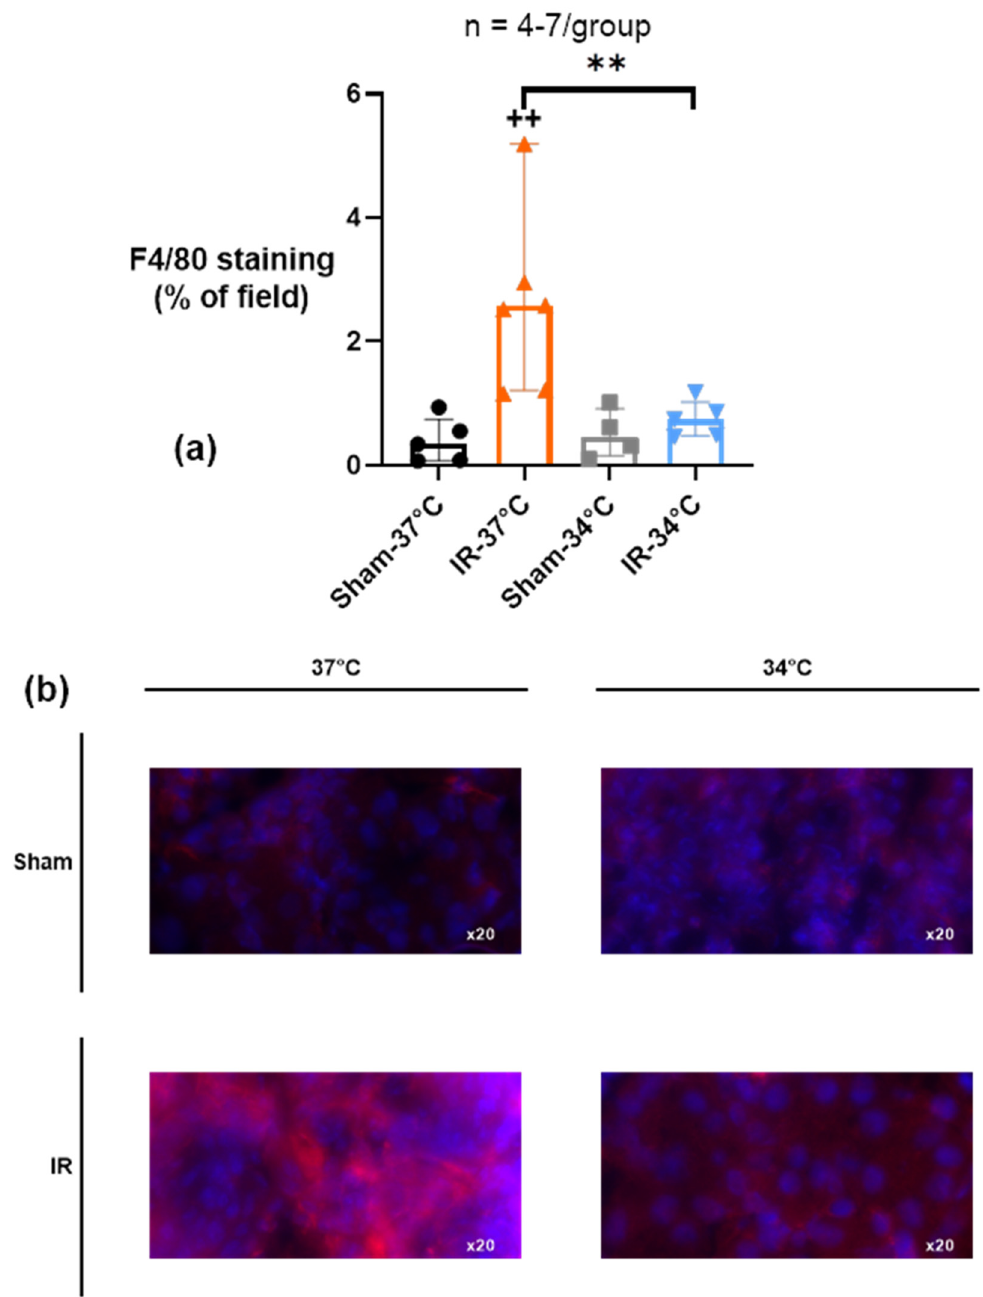
Figure 8. ( a ) F4/80 staining (red) assessed by immunofluorescence in ischemic kidney after 15 min of unilateral renal ischemia where the mice body temperature was maintained at normothermia (IR-37 ◦ C) or at mild therapeutic hypothermia (mTH) (IR-34 ◦ C), followed by 1 month of reperfusion, or after a Sham procedure with the same body temperature (Sham-37 ◦ C and Sham-34 ◦ C). After 1 month, renal ischemia-reperfusion induced a significant infiltration of macrophages in the kidney tissue, which was prevented by mTH. ( b ) Representative images of 8- µ m sections of immunostained kidney. Nuclei were stained with DAPI (blue). Data are shown as median with interquartiles. One data point in the IR-37 ◦ C group is outside the axis limit (value of 13.07) for better vizualisation. ** p < 0.01, Mann–Whitney test. ++ p < 0.01 vs. Sham-37 ◦ C, Mann–Whitney